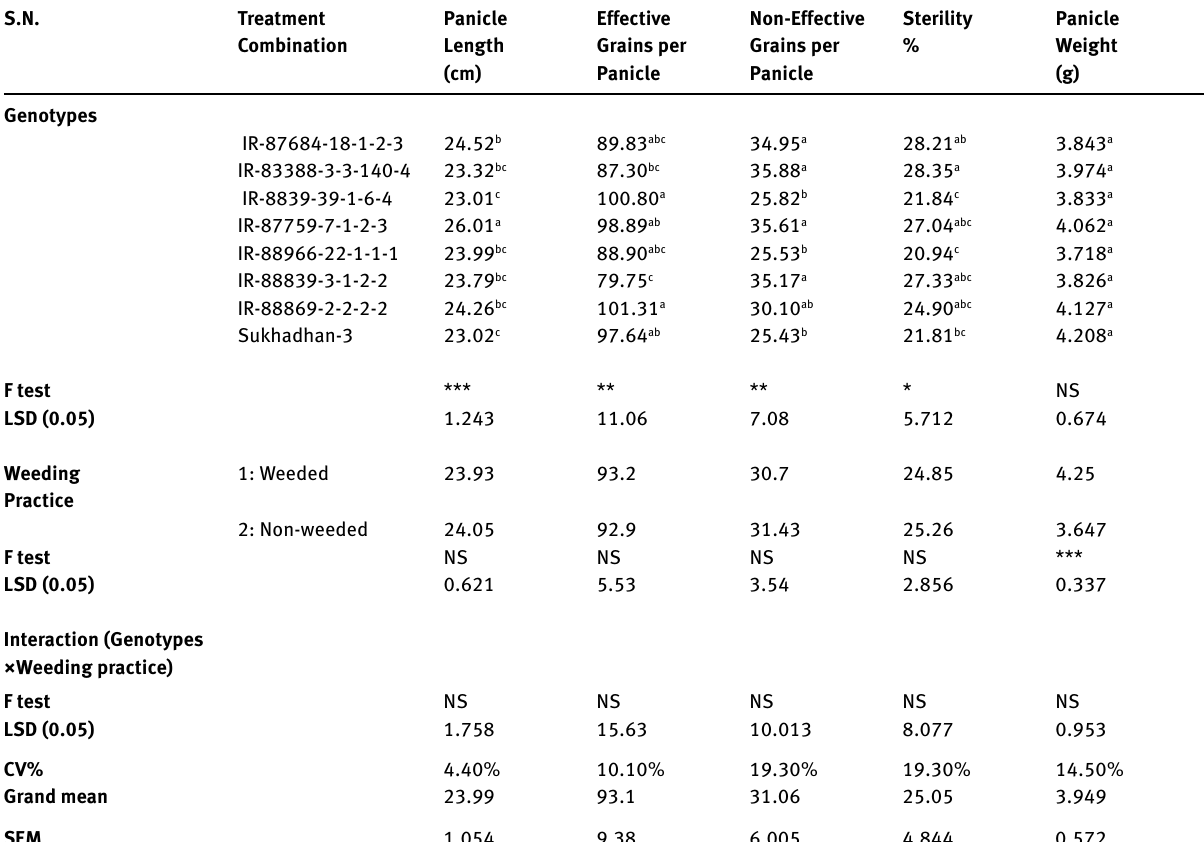
Table 3: Effect of genotypes, weed management practices and their interaction on yield attributing traits of rice genotypes at Lamjung, Nepal, 2016 S.N.